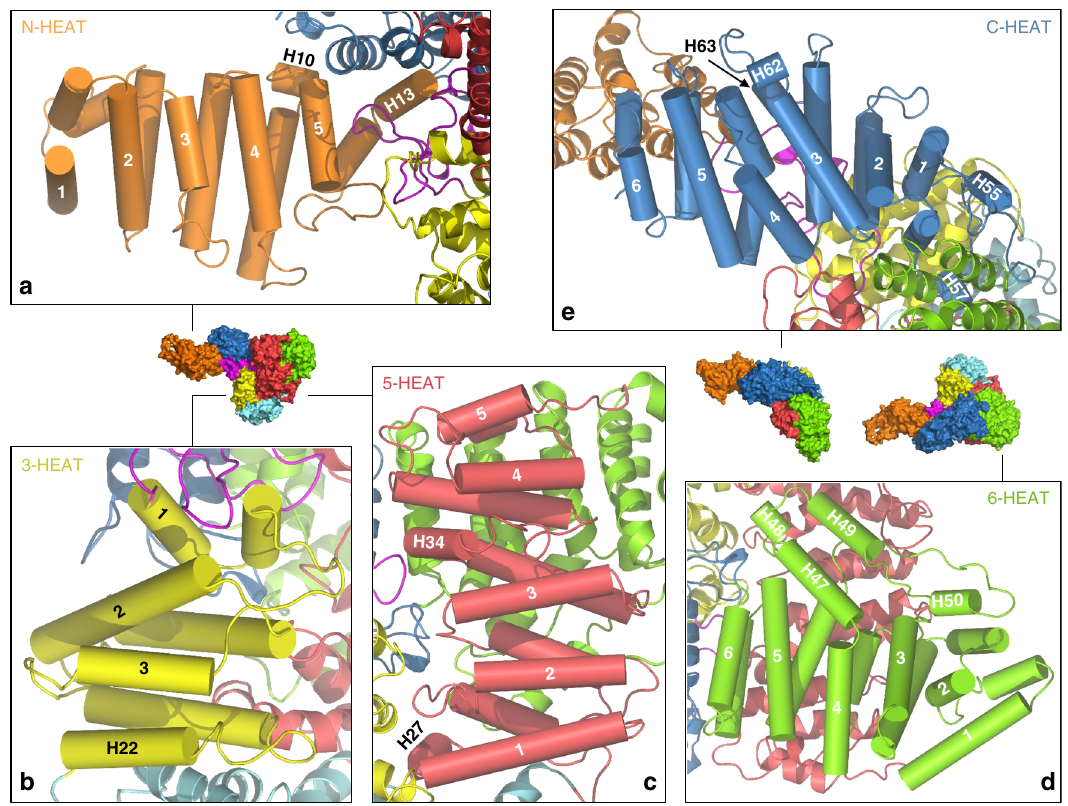
Fig. 2 Structure of MED23 solenoid domains. a N-HEAT domain, with the fi ve HR motifs labeled. H10 and H13, which pack against C-HEAT and, for the later, connects N-HEAT to the linker, are indicated. b 3-HEAT domain, with three HR motifs. H22, which connects 3-HEAT to the bridge domain, is indicated. c 5-HEAT domain, with fi ve HR motifs. H34 disrupts the solenoid between HR motifs 3 and 4 and is indicated. HR motifs 2 − 5 are positioned in front of HR motifs 4 − 6 from the 6-HEAT domain, in green in the background. d 6-HEAT domain, in green, with six HR motifs. The insertion between HR motifs 4 and 5 also contains an HR motif (helices 47 and 49) encompassing helix H48, positioned at the center of Core MED23. These three helices cover HR motifs 1 and 2 as well as helix H27 from 5-HEAT. e C-HEAT, with six HR motifs. HR motif 1 stacks against the last HR motif from the 6-HEAT domain. HR motifs 2 − 6 form a solenoid closely resembling that of N-HEAT. Color code is as in Fig. 1. The orientation of MED23 with respect to Fig. 1 is also